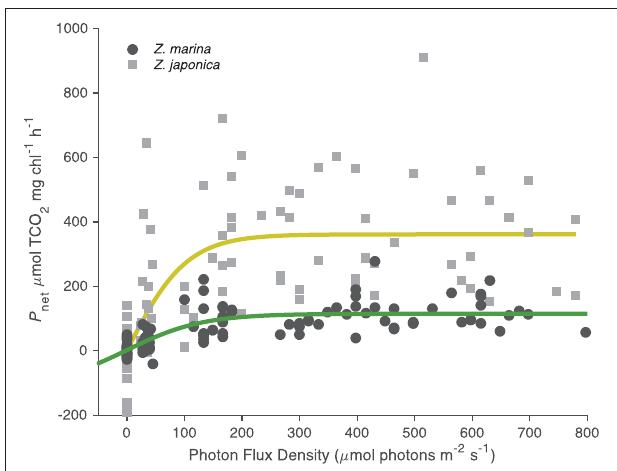
FIGURE 1 | Photosynthetic-irradiance curves for Z. marina (closed circles) and Z. japonica (closed squares). Net photosynthetic rates ( µ mol TCO 2 mg chl − 1 h − 1 ) collated for all initial TCO 2 treatments from experimental 90 min incubations. Fitted lines are the estimated curve from the TCO 2 -irradiance model (Equation 3). All negative data points indicate respiration ( µ mol TCO 2 mg chl − 1 h − 1